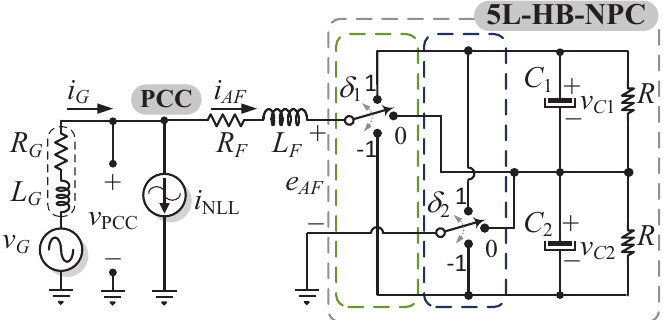
Figure 2. Equivalent diagram of the SAPF based on the 5L-HB-NPC topology with the switching functions δ 1 and δ 2